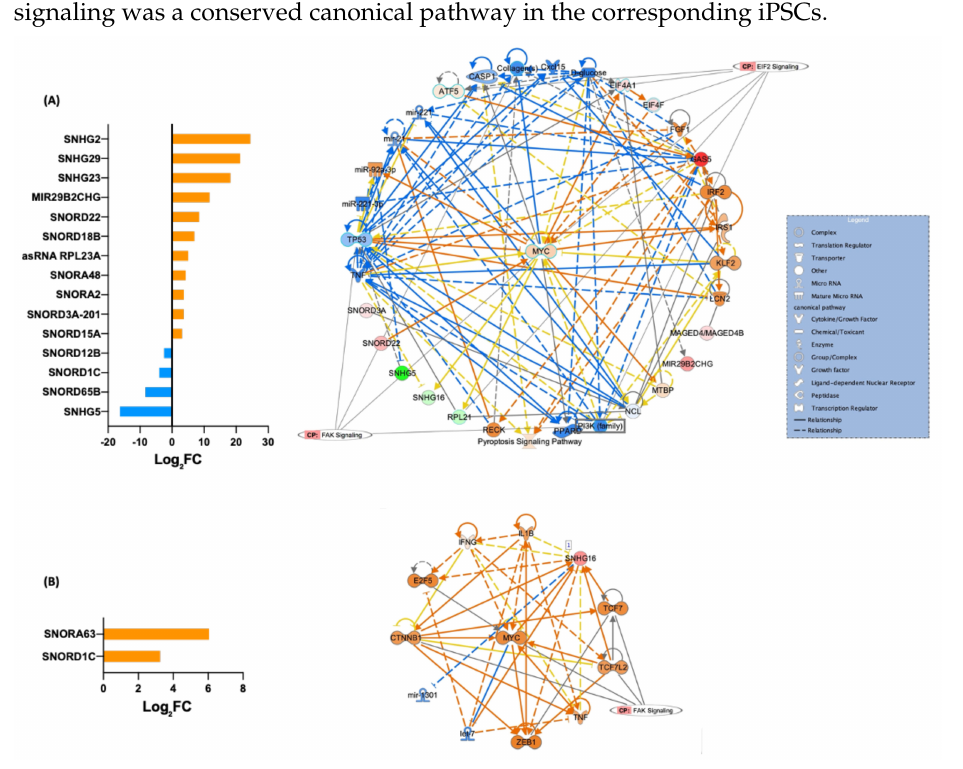
Figure 7. Other differentially expressed ncRNAs in fibroblasts and their iPSCs and the predicted canonical pathways. ( A ) DE snRNAs in fibroblasts with higher reprogramming efficiency and predicted canonical pathways. ( B ) DE snRNAs in iPSCs with higher reprogramming efficiency and predicted canonical